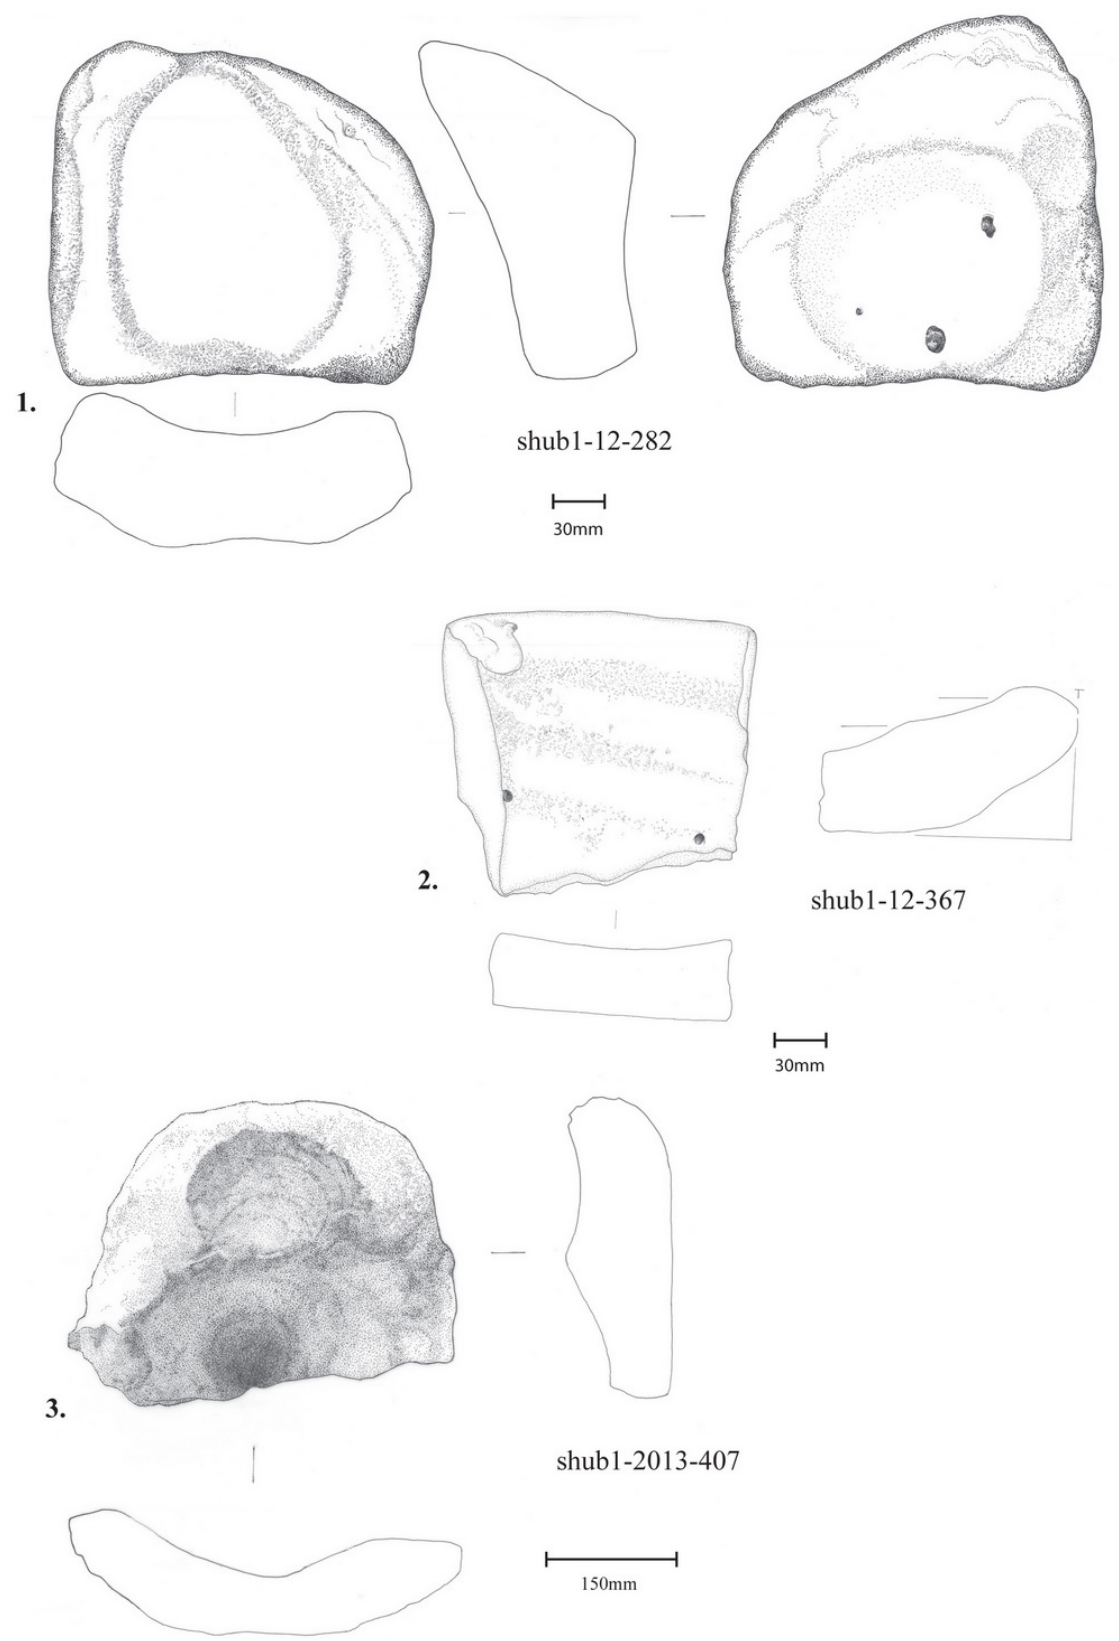
Figure 7: Lower Grinding Implements (LGI). No. 1: Complete quern of the type “opposed-faced double quern” (ODQ), No. 2: Fragment of the “stepped-faced quern” (SFQ) type, No. 3: Broken flagstone with cup-hole and mortar hole lifted from the floor surface of Structure 2, late Natufian phase of Shubayqa